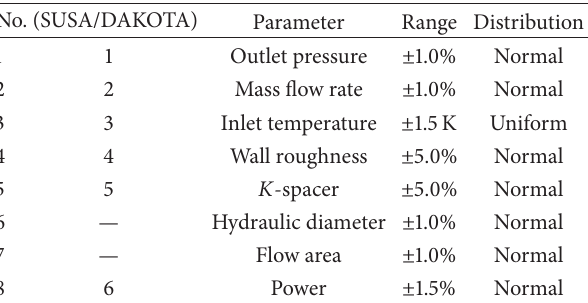
Table 2: Uncertain parameters. No.